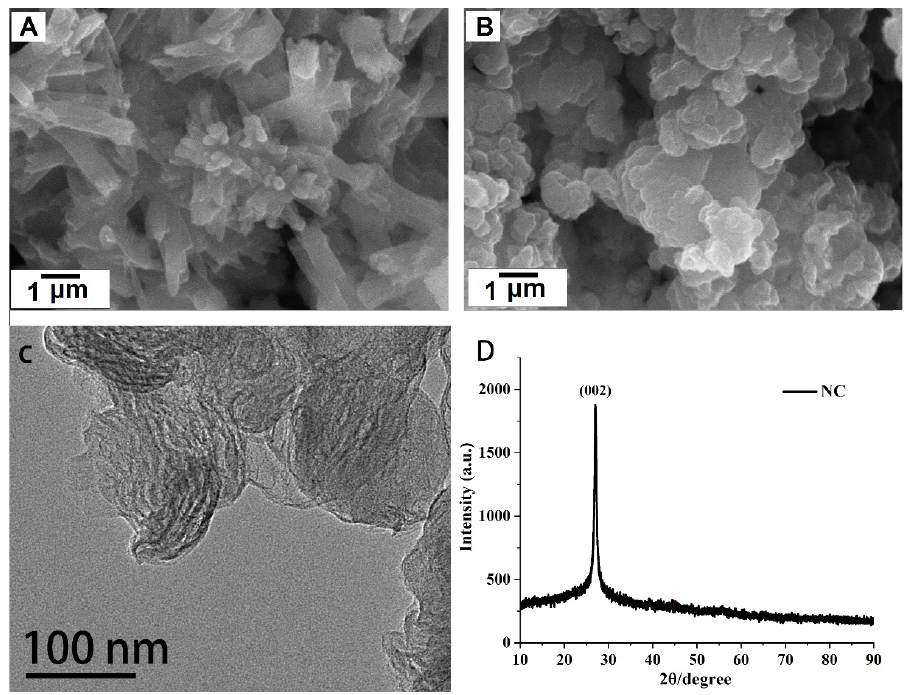
Figure 1. SEM images of f-NC1 ( A ) and f-NC2 ( B ); TEM image of f-NC2 ( C ) and XRD pattern of f-NC2 ( D ).